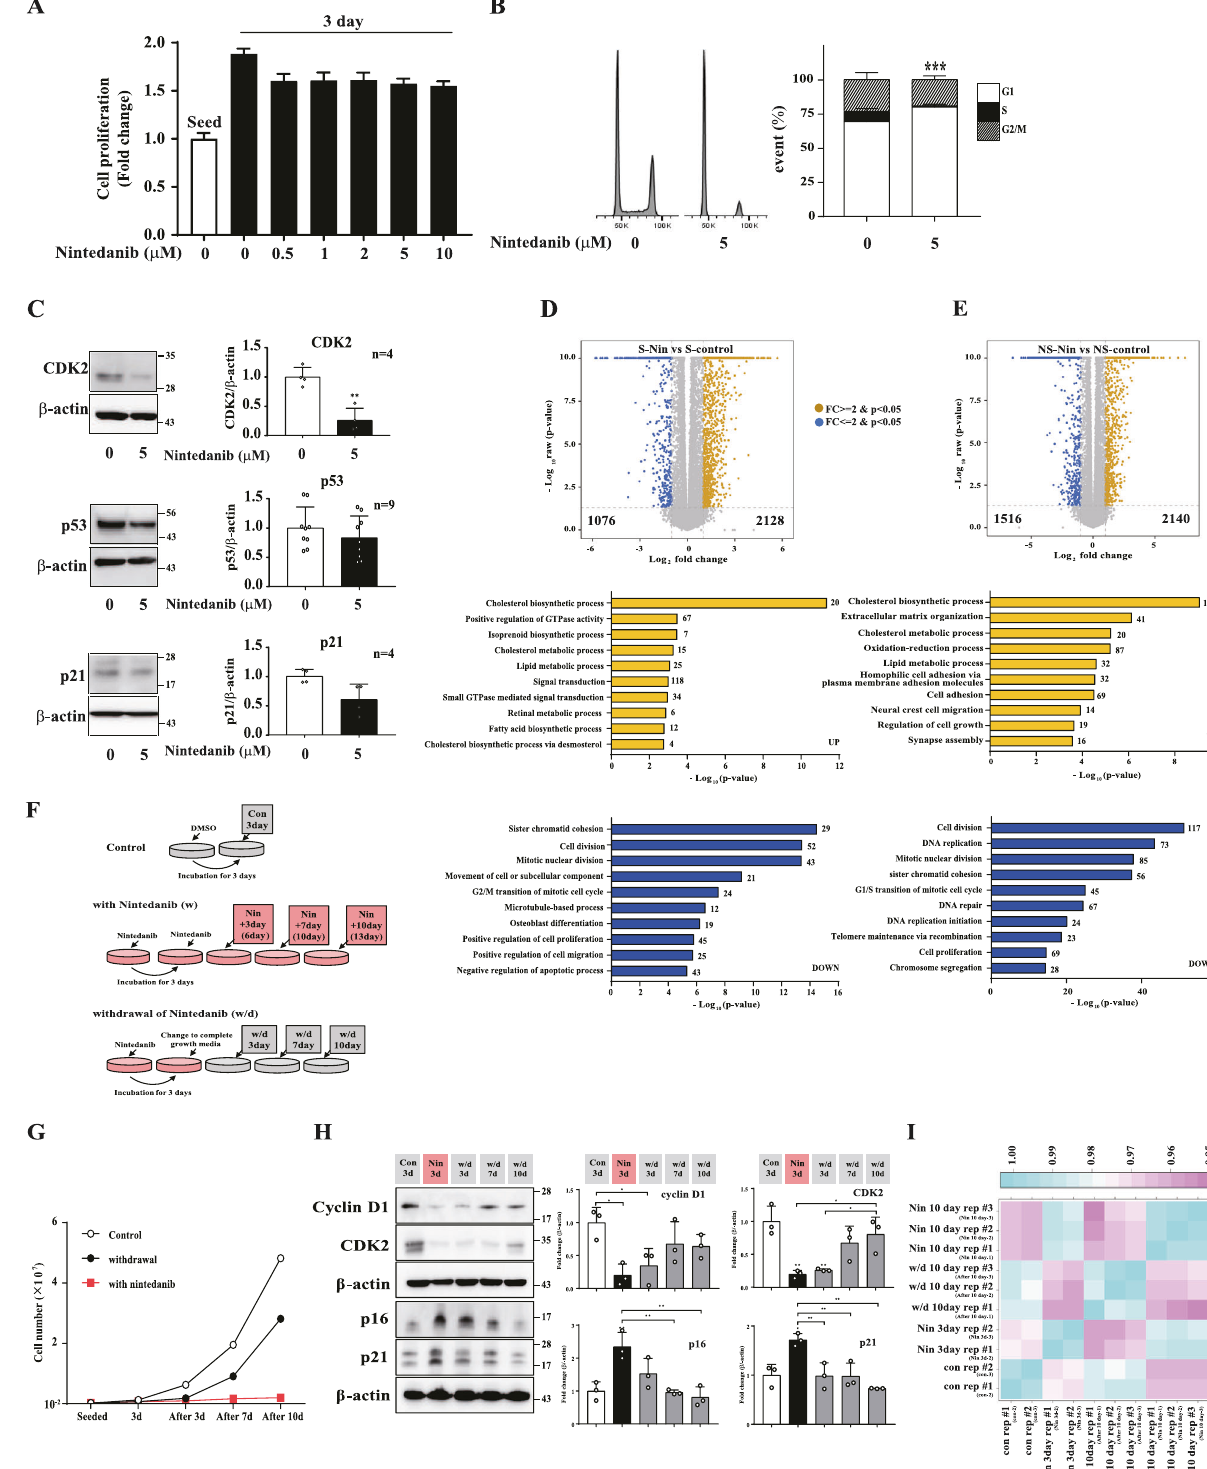
plot). In nonsenescent HDFs treated with nintedanib, 2140 upregulated genes and 1516 downregulated genes were identi- fi ed (Fig. 3E, volcano plot). For systematic analysis of biological processes affected by the senescence-dependent effects of nintedanib, we performed a GOBP enrichment analysis of the up- and downregulated genes in the cells in each senescent state Cell Death and Disease (2022)